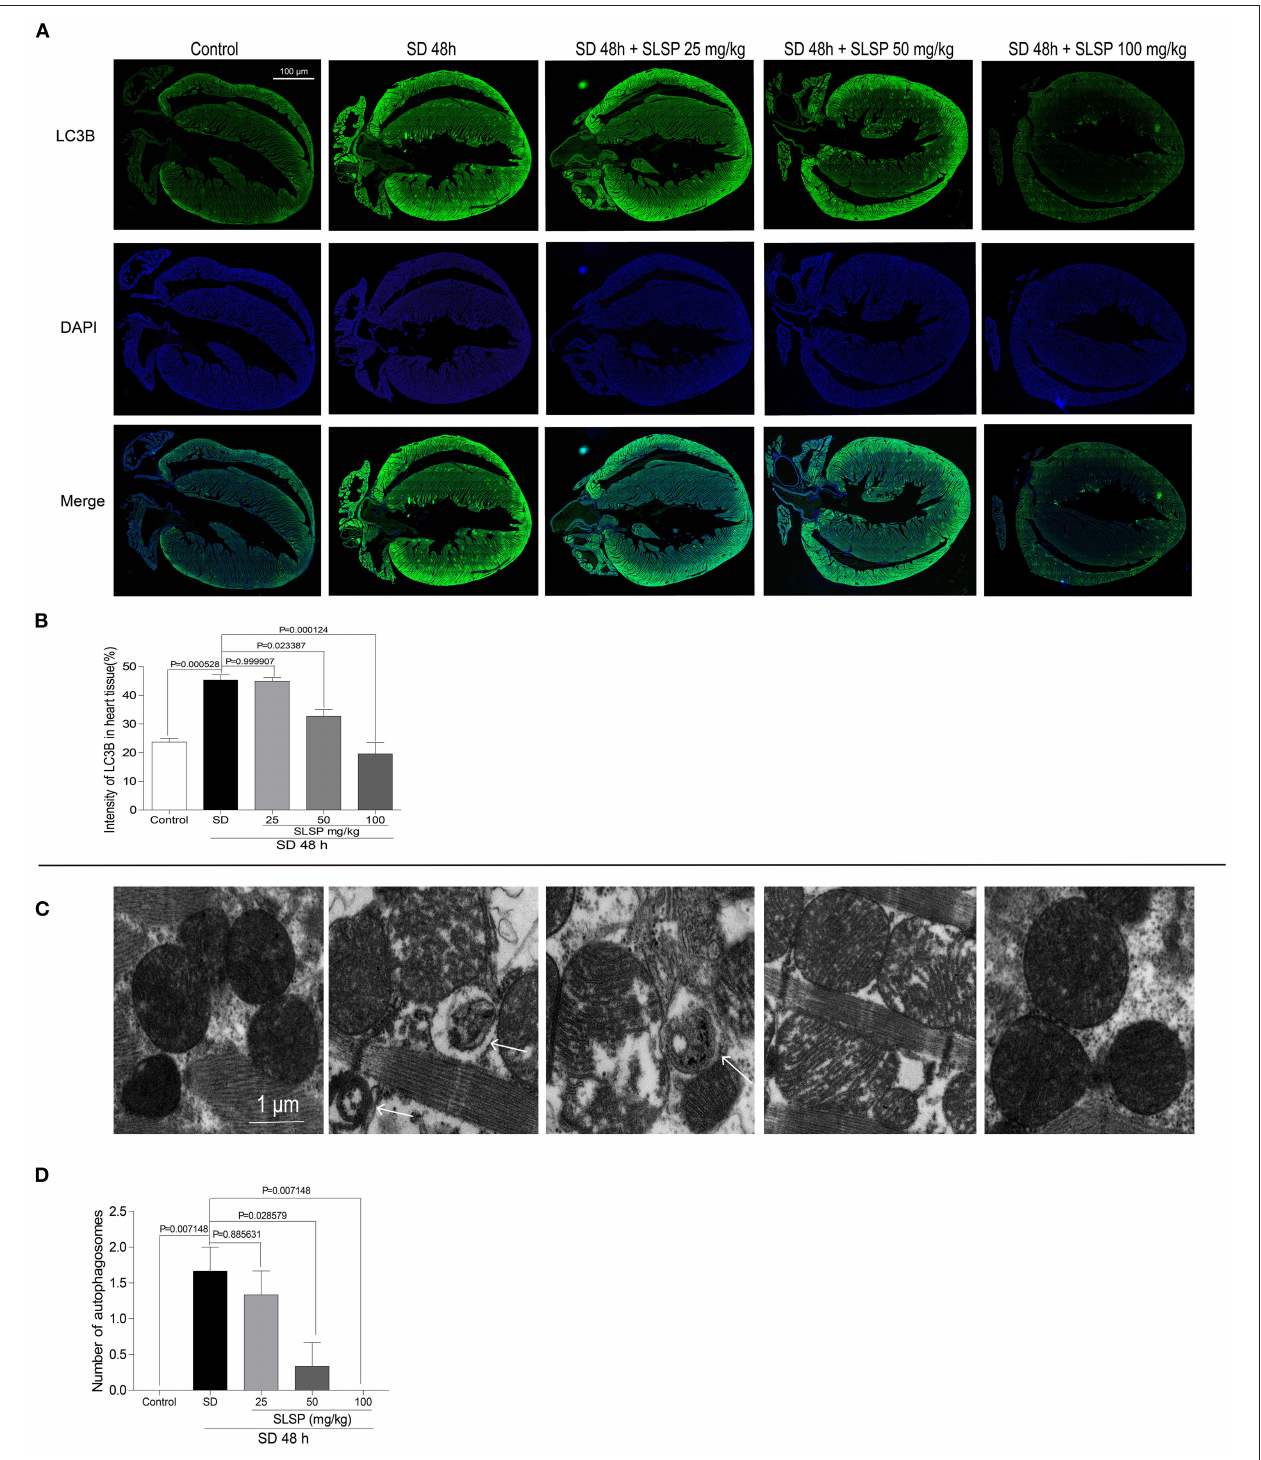
FIGURE 3 | SLSP suppressed the formation of autophagosomes and the increase of LC3B in the heart tissue of SD mice. (A) Expression of LC3B in heart tissue of mice by IHC. (B) Intensity of LC3B in heart tissue. (C) Transmission electron microscopy (TEM) images of heart tissue. (D) Number of autophagosomes exposed by TEM in heart tissue. N =